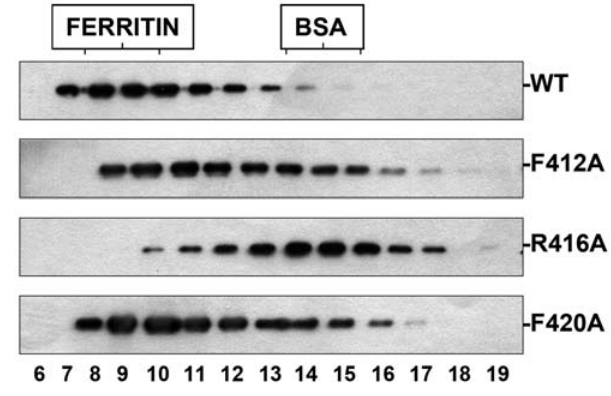
Figure 8. Homopolymerisation of wt or mutant NP. The aggregation state of wt or mutant NPs was determined by gel filtration. Cultures of COS1 cells were transfected with plasmids expressing either wt of mutant NP, as indicated, and total cell extracts were treated with RNAse and filtered on a Sephacryl S300 column. The eluted fractions were analysed by Western-blot with anti-NP antibodies. The position of ferritin (440 kDa) and bovine serum albumin (BSA; 67 kDa) is shown on the top of the